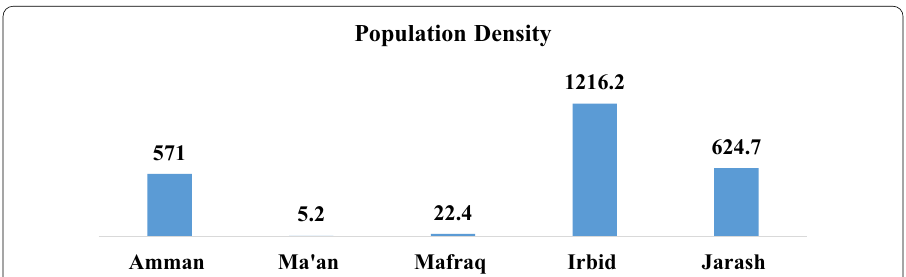
Fig. 1 Highest and lowest population density of the Jordanian